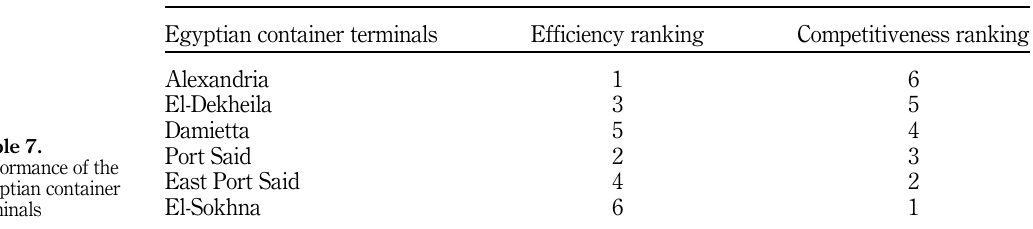
Egyptian container